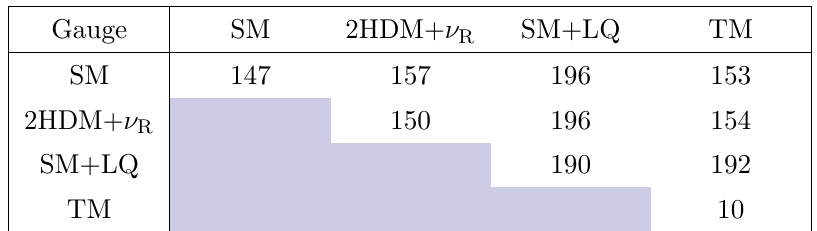
Table 1 . The number of independent constraints on the gauge coefficients from combining any two of the models, with the diagonal being the constraints from the individual models.